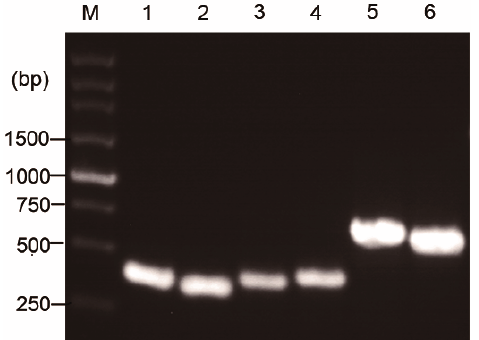
Figure 1. PCR products of PA-6-Fab expression vector. M : DNA marker; lane 1 : murine variable regions of the heavy chain (V H ); lane 2 : murine variable regions of the light chain (V ) ; lane 3 : human constant regions of the heavy chain domain 1 (C H 1); lane 4 : human L constant regions of the light chain domain (C L ); lane 5 : heavy chain Fd; lane 6 : light chain.